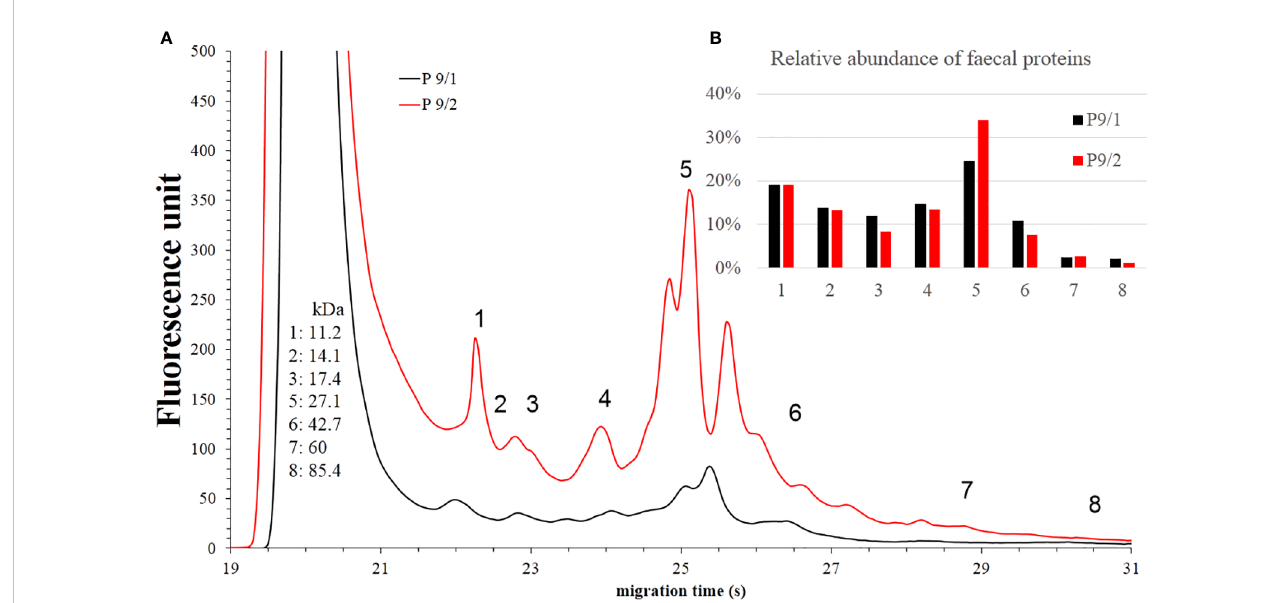
FIGURE 9 Faecal protein analysis (A) and relative abundance of faecal proteins (B) of Patient #9 before (black) and after (red) FMT. The numbered data points refer to different components. The molecular weights of the components can be seen on the left side in kilodaltons. Panel b shows the relative abundance of these